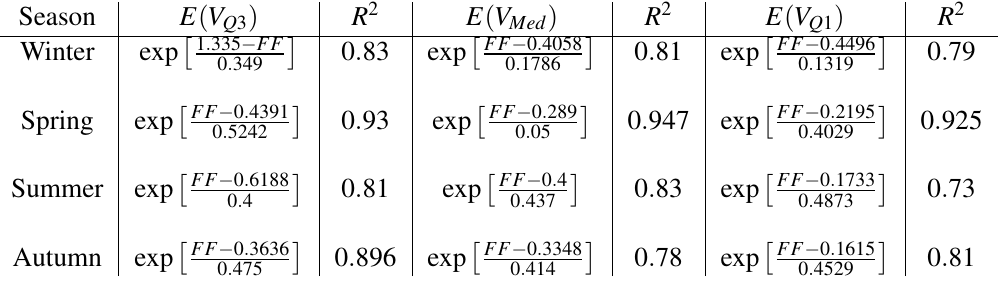
Table 5 Seasonal expected Q3, Median and Q1 of raptor flight results depending on the Feeding